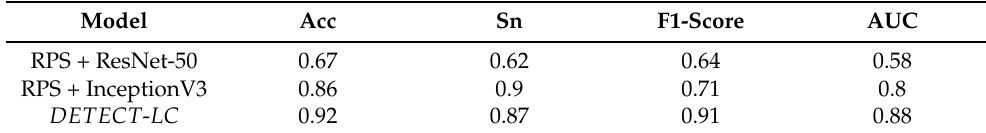
Table 5. Lung Cancer Phenotyping Performance Evaluation on NSCLC Radiomics-Genomics.